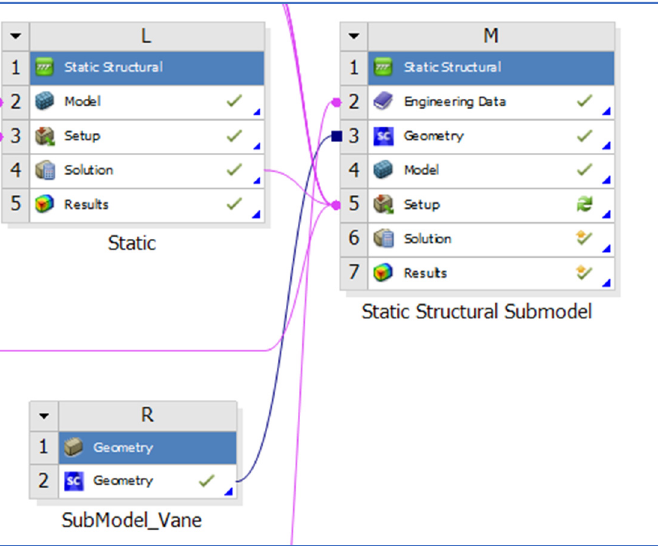
Figure 6. Sub-model attached to the engineering data and solution of the full model in ANSYS Workbench.